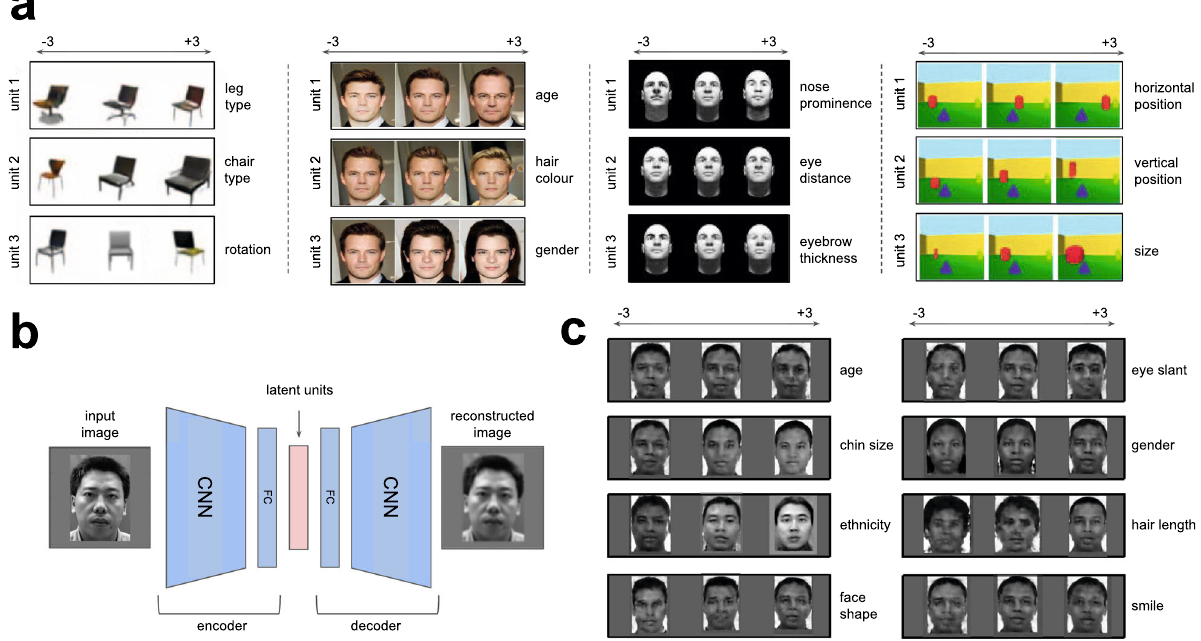
Fig. 1 Disentangled representation learning. a Latent traversals used to visualise the semantic meaning encoded by single disentangled latent units of a trained model. In each row the value of a single latent unit is varied between − 3 and 3, while the other units are fi xed. The resulting effect on the reconstruction is visualised. Each column represents a different model trained to disentangle a different dataset. Chair and face images in the leftmost two traversals are reproduced with the permission of Lee et al. 19 . Traversals of 3D scenes are reproduced with the permission of Burgess et al. 18 . b Schematic representation of a self-supervised deep neural network. The encoder maps the input image into a low-dimensional latent representation, which is used by the decoder to reconstruct the original image. Blue indicates trainable neural network units that are free to represent anything. Pink indicates latent representation units that are compared to neurons. CNN, convolutional neural network. FC, fully connected neural network. Face image reproduced with permission from Gao et al. 57 . c Latent traversals of eight units of a β -VAE model trained to disentangle 2100 natural face images. The initial values of all latent units were obtained by encoding the same input image.